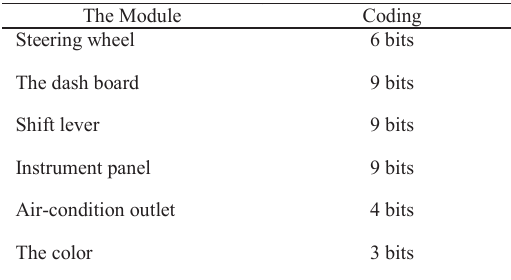
Table 1. Partial Constraint of Console